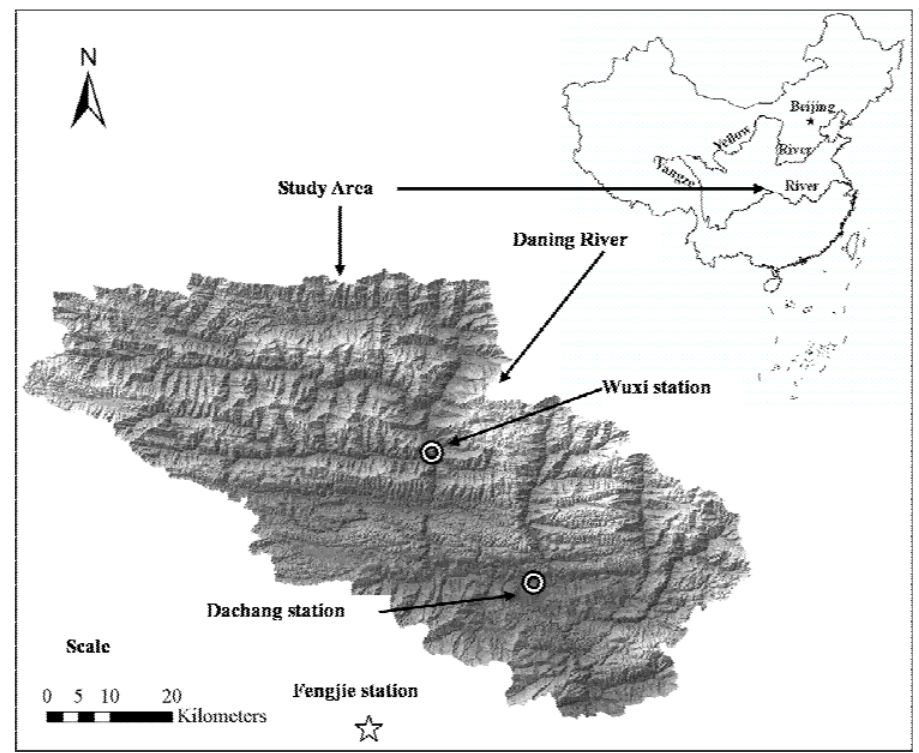
Figure 6. Location of the study